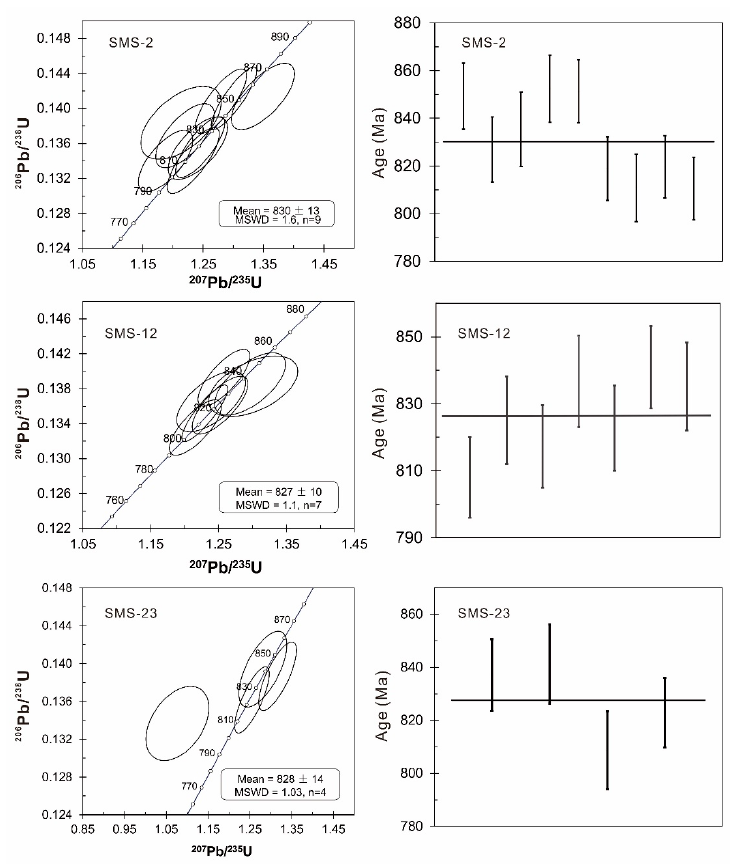
Figure 8. SHRIMP zircon U–Pb concordia diagram of the Shimensi granodiorite.